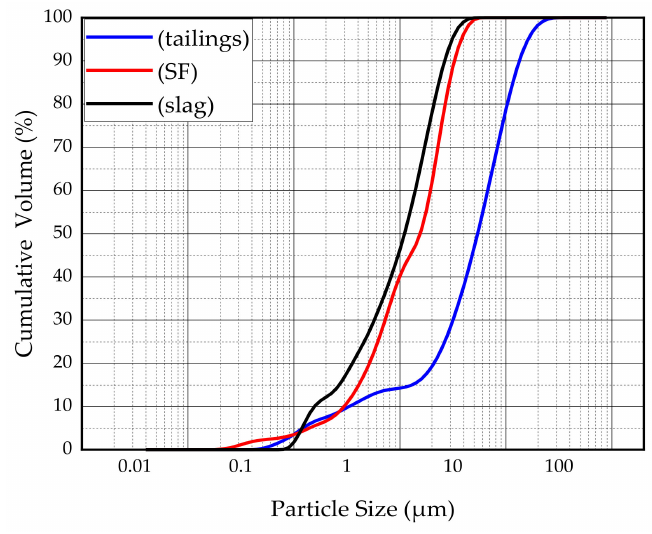
Figure 1. Particle size distribution of the tailings and binders.